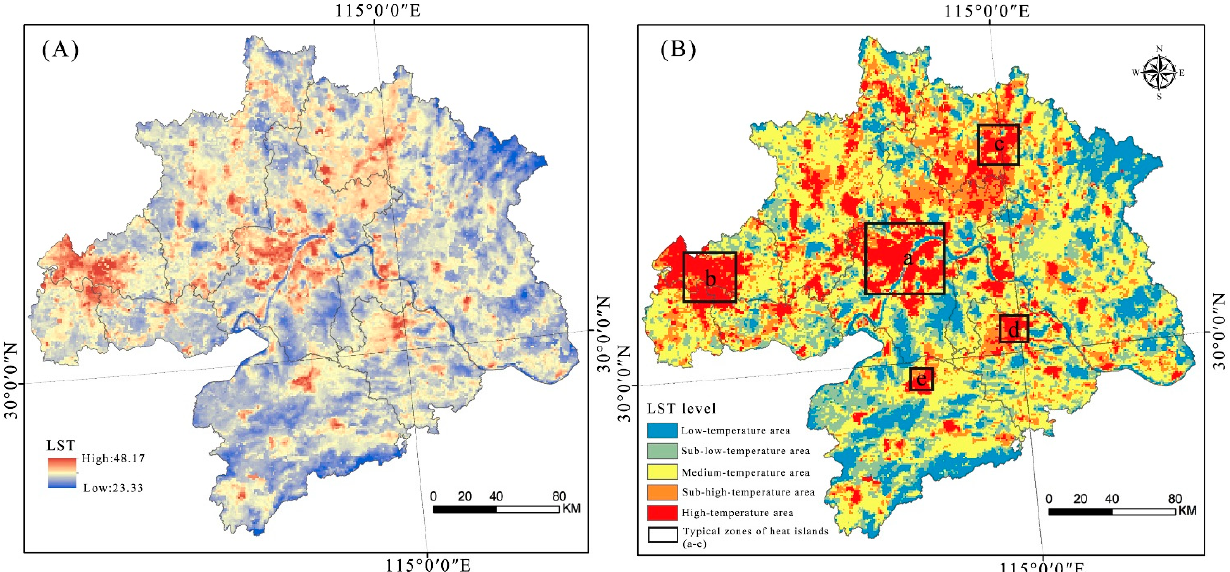
Figure 3. Study area LST ( A ) and LST level ( B ).